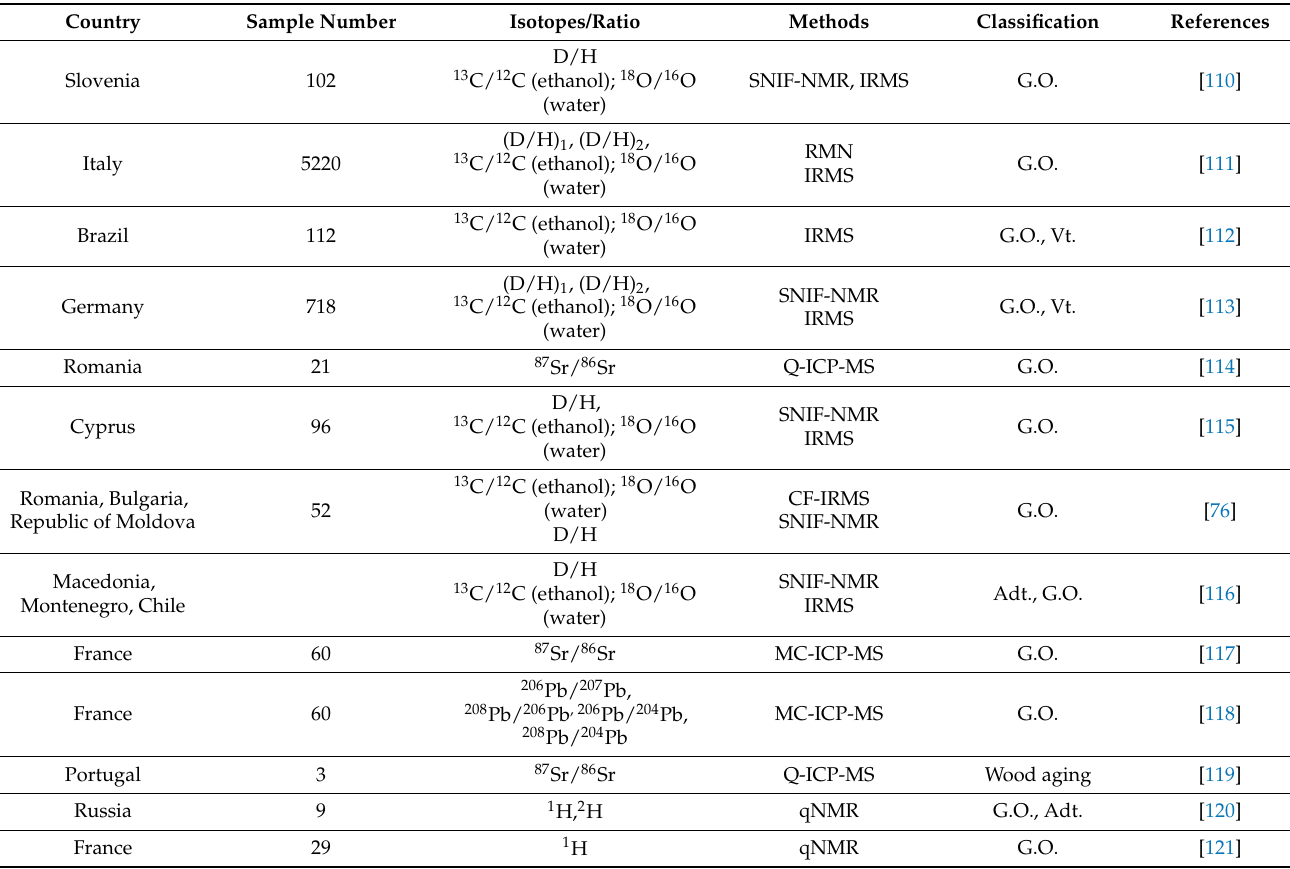
Table 4. Studies using isotopic analysis to confirm the authenticity of